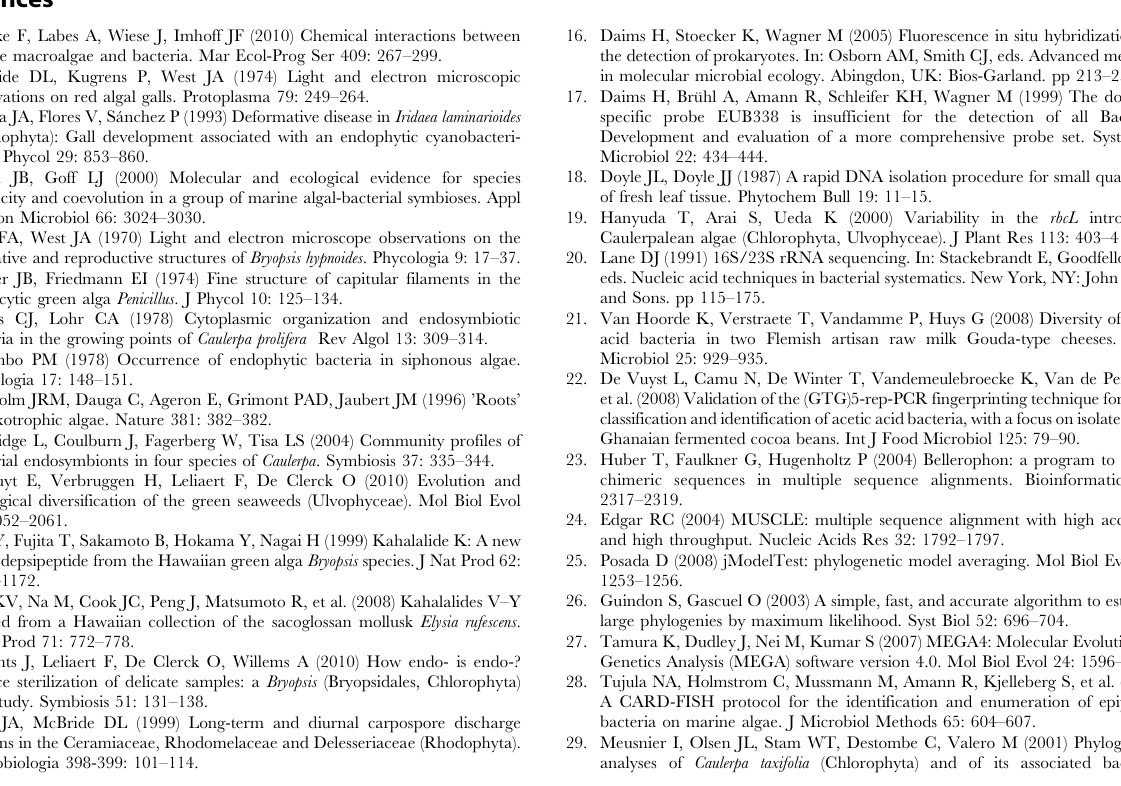
Figure 5. A wide-range maximum likelihood tree showing the phylogenetic positions of endophytic clones and DGGE bands. Phylogenies were inferred from 16S rRNA gene sequences determined in this study (in bold), BLAST hits (see Table 1), Bacteroidetes, Proteobacteria and Mollicutes type strains, and algae-associated bacteria described in the literature (see Table S1). The tree was generated in PhyML according the HKY + G4 algorithmic model. Bootstrap values above 50% are indicated at the branch nodes and the scale bar shows 10 nucleotide substitutions per 100 nucleotides. Asterisks denote sequences previously isolated from micro * - and macroalgae**. The same phylogenetic tree without compressed branches is depicted in Figure